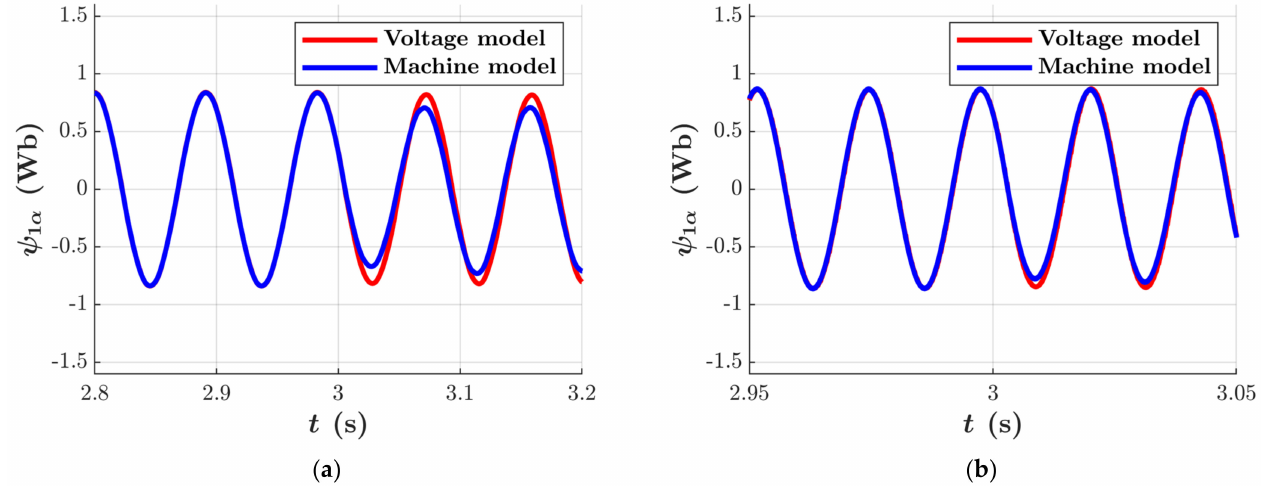
Figure 8. The effect of inverter nonlinearities on the accuracy of stator flux linkage estimation at different operating points. ( a ) 20% of the nominal speed and torque; ( b ) 80% of the nominal speed and torque. Inverter nonlinearity turned on at 3 s.